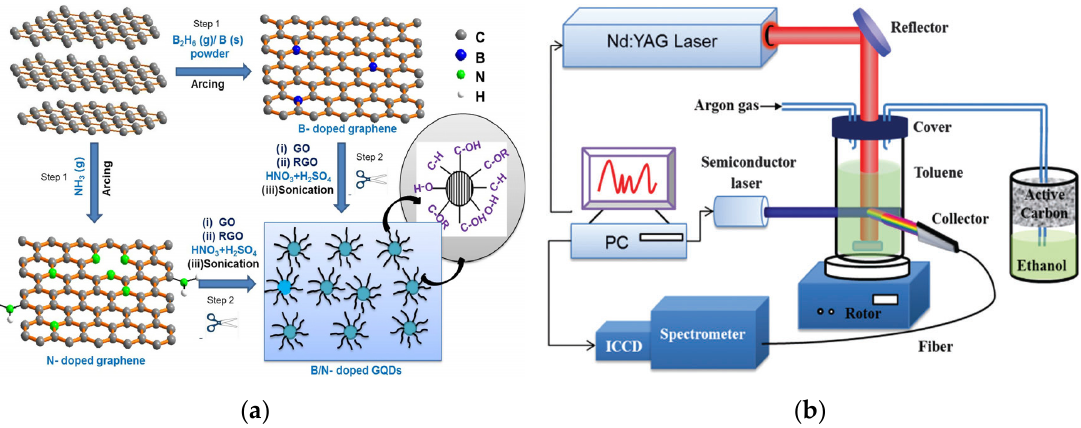
Figure 1. ( a ) Schematic of the synthesis of B/N-carbon quantum dots (CQDs) (Step1: synthesis of doped graphene by arc discharge; Step2: chemical shearing process of graphene sheets). Reproduced with permission from [40]. Copyright Chemical Physics Letters, 2014; ( b ) Schematic illustration of the device of laser ablation synthesis of CQDs. Reproduced with permission from [43]. Copyright Chemical Communications, 2016.